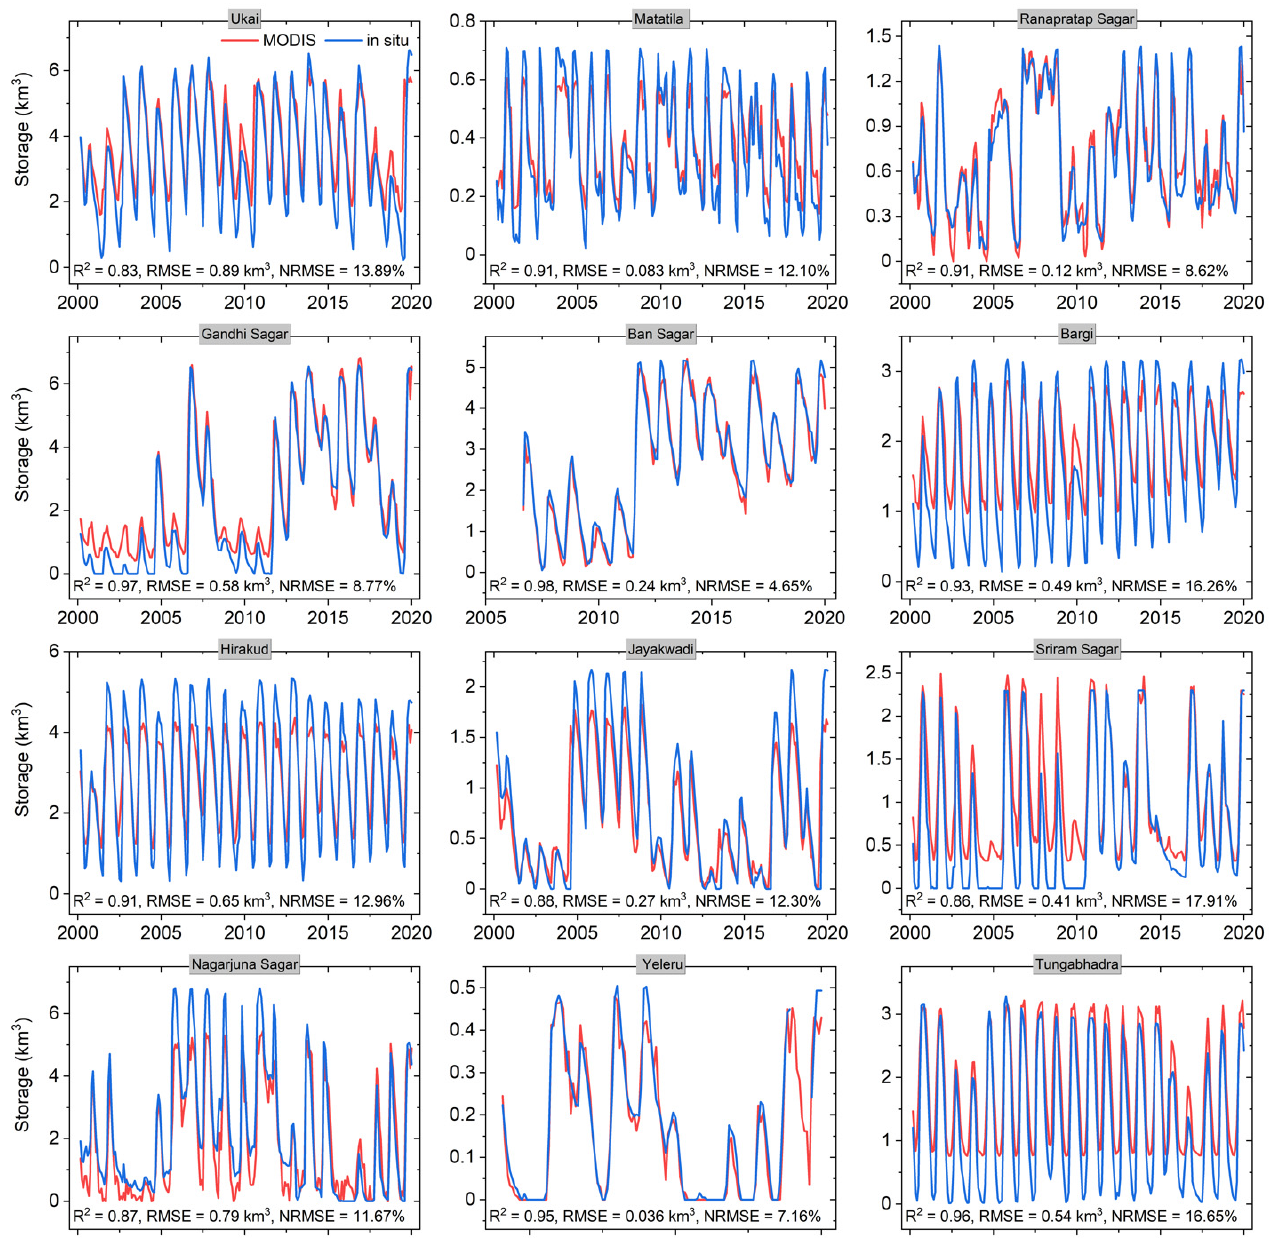
Figure A2. Validation of monthly storage products for twelve Indian reservoirs from 2000 to 2019.